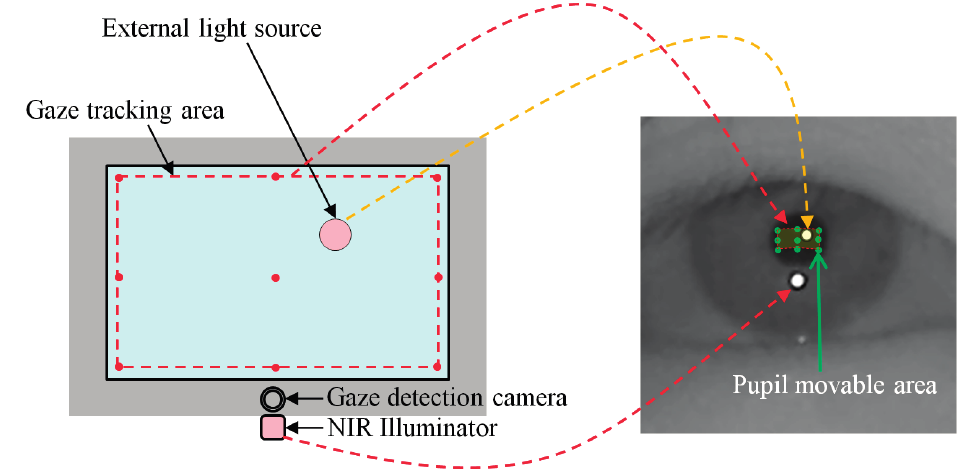
Figure 17. Eye image in presence of external light in a car